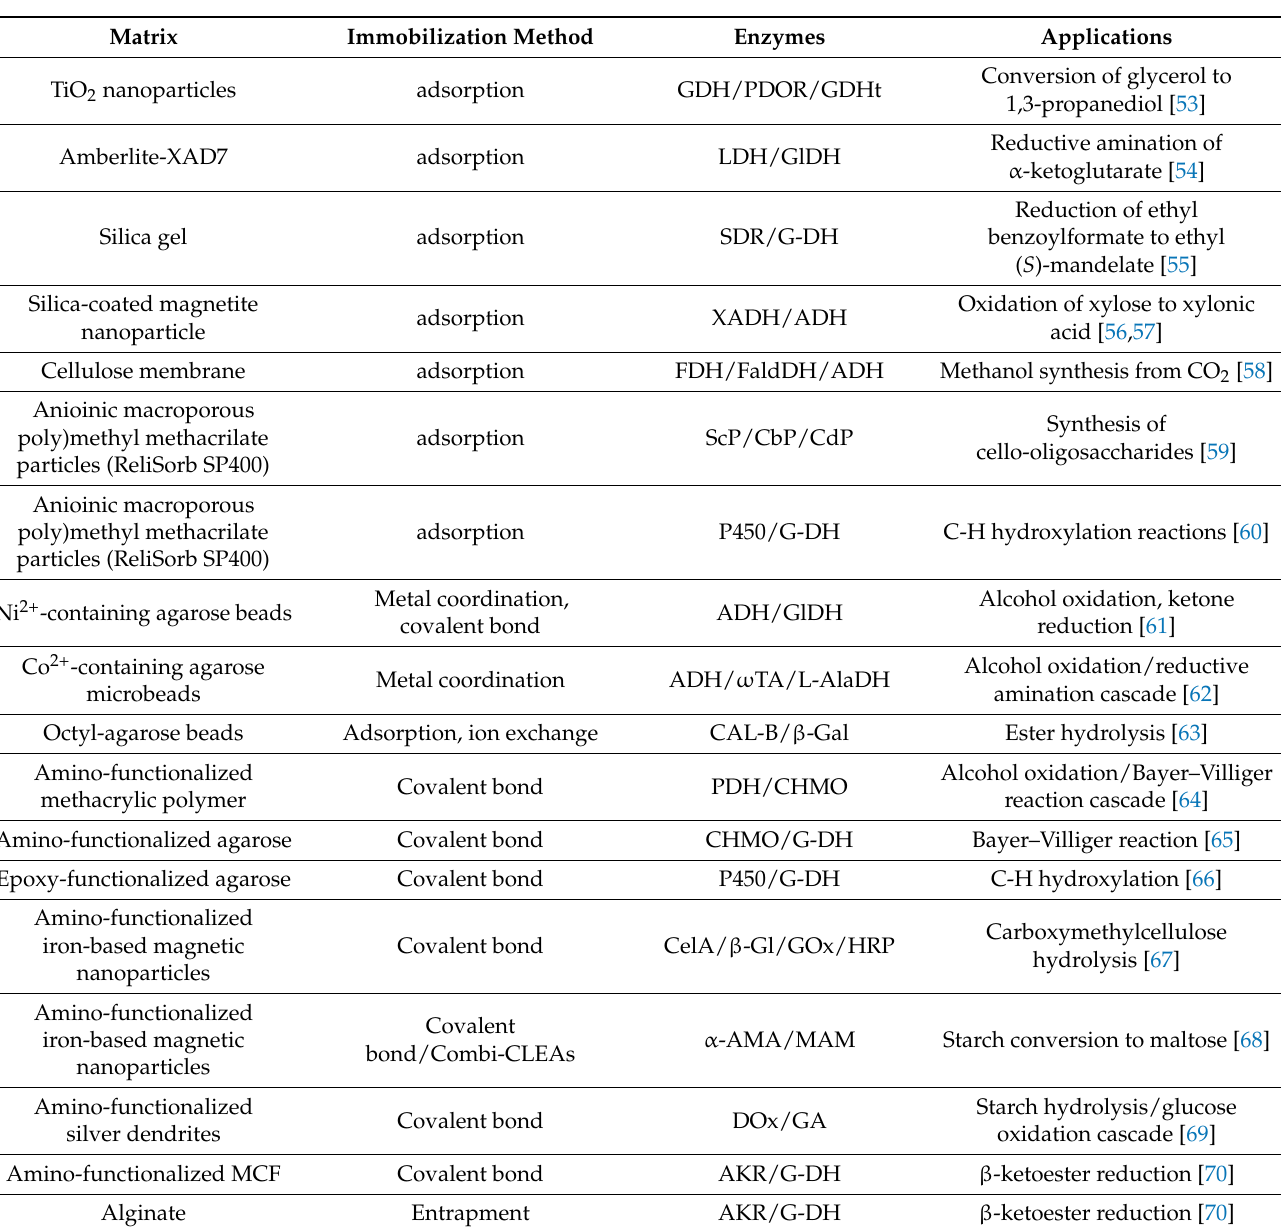
Table 1. Matrices used for co-immobilization of enzymes for synthetic purposes. GDH = glycerol dehydrogenase, PDOR = 1,3- propanodiol oxidoreductase, GDHt = glycerol-dehydratase, LDH = lactate dehydrogenase, GlDH = glutamate dehydrogenase, SDR = short-chain dehydrogenase/reductase from Thermus theruophiles , G-DH = glucose dehydrogenase, XDH = xylose dehydrogenase, ADH = alcohol dehydrogenase, FDH = formate dehydrogenase, FaldDH = formaldehyde dehydrogenase, ScP = sucrose phosphorylase, CbP = cellobiose phosphorylase, CdP = cellodexrtin phosphorylase, ω TA = ω -transaminase, L- AlaDH = L-alanine dehydrogenase, CAL-B = Candida antarctica B lipase, β -Gal = β -galactosidase, PDH = polyol dehydrogenase, CHMO = cyclohexanone monooxygenase, CelA = cellulase, β -Gl = β -glucosidase, GOx = glucose oxidase, α -AMA = α - amylase, MAM = maltogenic amylase, HRP = horseradish peroxidase, GA = glucoamylase, MCF = mesocellular siliceous foam, AKR = aldo-keto reductase, D-HA = D-hydantoinase, D-CA = D-carboamylase, DKR = dynamic kinetic resolution, PaoABC = periplasmic aldehyde oxidase, CAT = catalase, β -FFA = β -fructofuranosidase, MOF = metal–organic framework, CA = carbonic anhydrase, AGE = N -acyl-D-lucosamine-2-epimerase, NAL = N -acetylneuraminate lyase, CSS = CMP-syalic acid synthetase, CMP = cytidine monophosphate, BDH = 2,3-butanediol dehydrogenase, P450 = monooxygenase from cytochrome P450, NHS = N